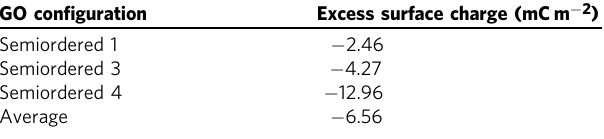
Table 4 Excess charge/GO surface (in mC m − 2 ) on the GO interfacing bulk water (equivalent with opposite sign to the excess charge distributed over the H 2 O molecules of the bulk).